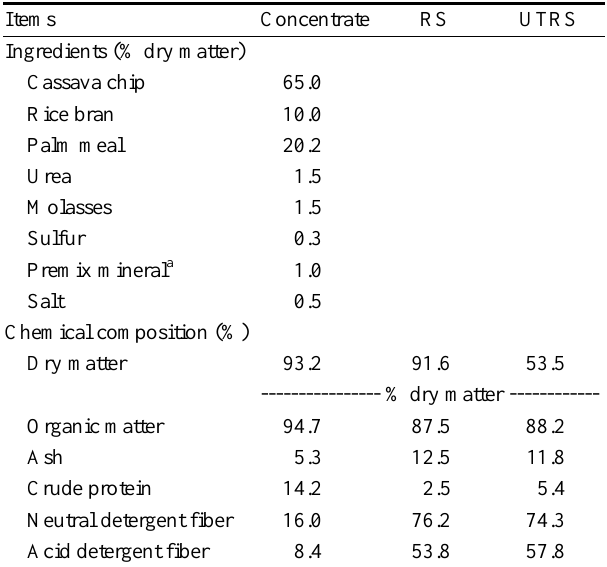
Table 1. Ingredients and chemical compositions of concentrate, rice straw and urea treated rice